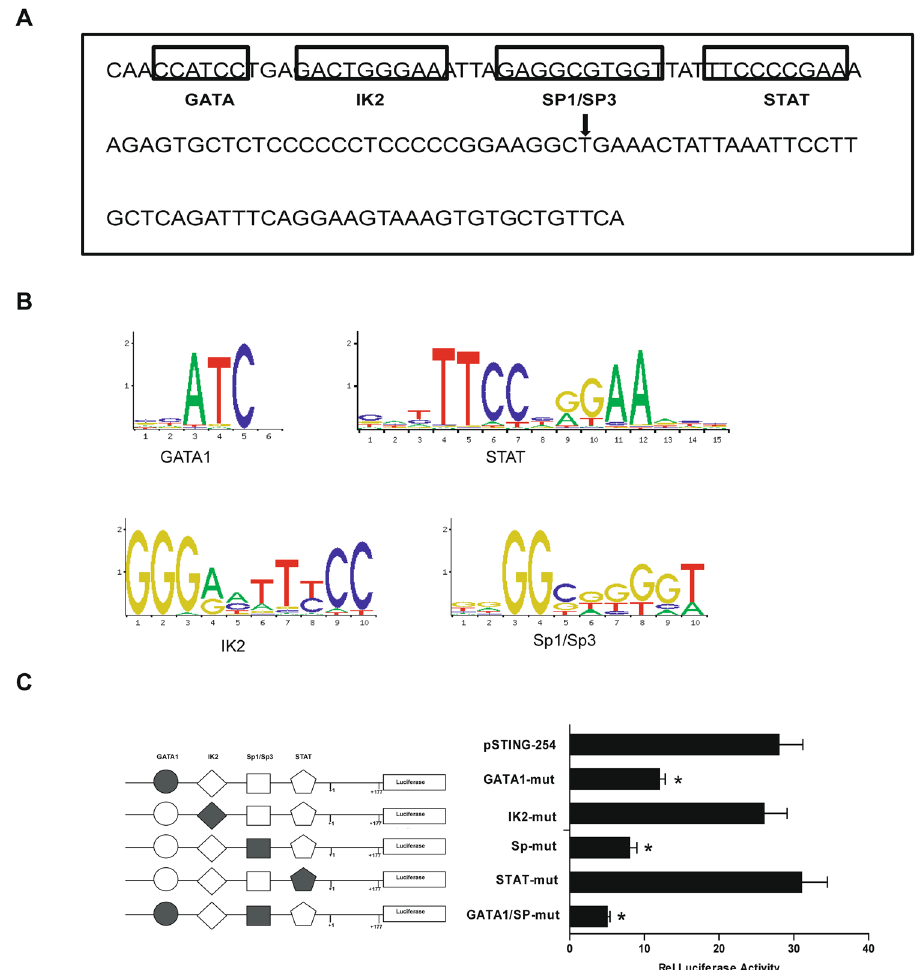
Figure 3. Prediction of transcription factor binding sites and mutation analysis of the mSTING minimal promoter. ( A ) A schematic representation of the putative binding sites for DNA-binding proteins in the proximal promoter of the mSTING gene. The 129 nt DNA sequence (from − 77 to + 52) was analyzed with TFSEARCH softwares. The putative transcription factor binding sites were outlined with black box, and the names of the transcription were annotated. The transcription start site (TSS) was marked by black arrow. ( B ) Conserved base sequence of GATA1, IK2, Sp1/Sp3 or STAT binding site. The base size presented the binding affinity coefficient of transcription factor and promoter. ( C ) Mutation analysis of the mSTING minimal promoter. The left: Binding sites for GATA1, IK2, Sp1/Sp3 and STAT were indicated with open different shapes. Mutations were shown in bold above the histogram. The right: The relative luciferase activities derived from mutational pSTING-254. The site-special mutagenized plasmids were cotransfected with pRL-TK into NIH3T3 cells and lucifarase assays were performed. The level of firefly luciferase activities was normalized to the Renilla luciferase activity. Each bar represented the mean ± SD of three independent experiments. (n = 3, * p < 0.05 vs.